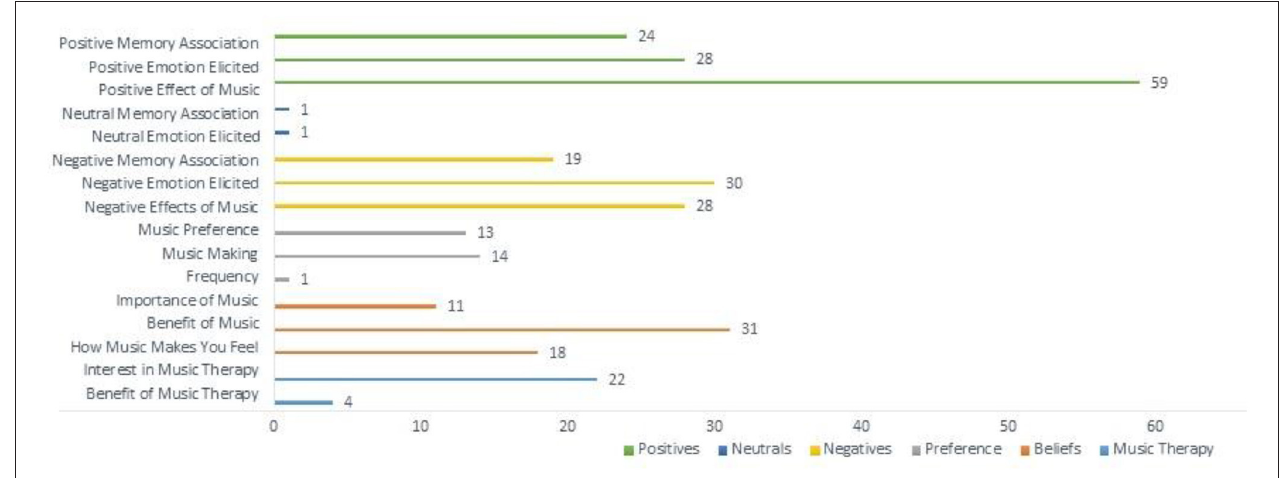
FIGURE 1 | Distribution of the frequency of themes coded from all 41